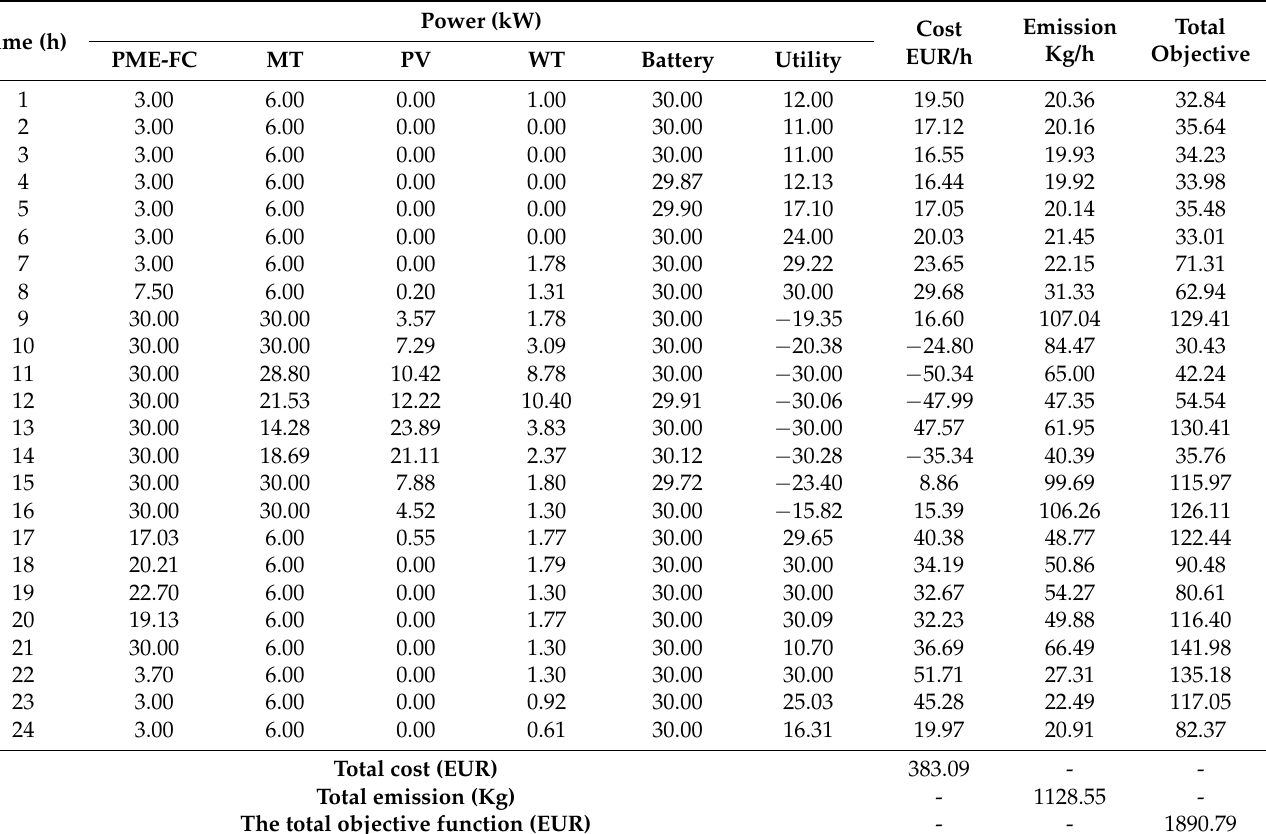
Table 12. The best results obtained using the EO for the EM problem in Case